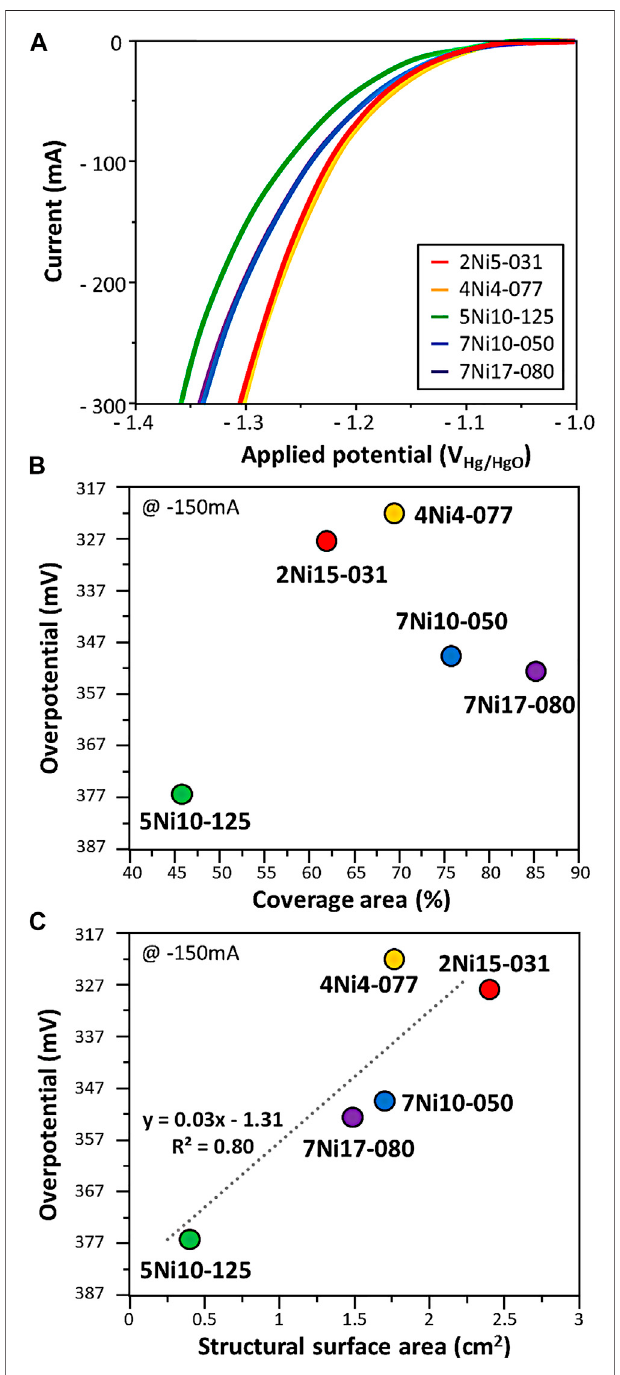
FIGURE 3 | (A) HERperformanceofexpandedmesh.Theoverpotentialat 150 mA current in HER with respect to (B) coverage area and (C) structural surface area. The dotted line is the linear regression plot obtained from the data.